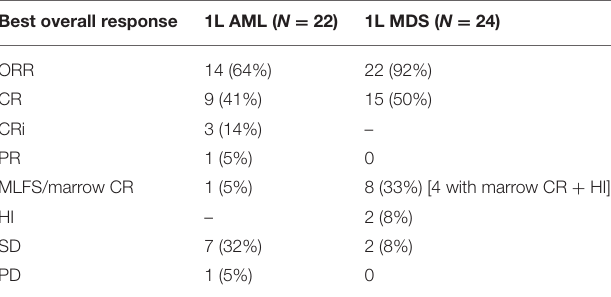
TABLE 3 | Efficacy of magrolimab + azacitidine in untreated AML and MDS patients. Best overall